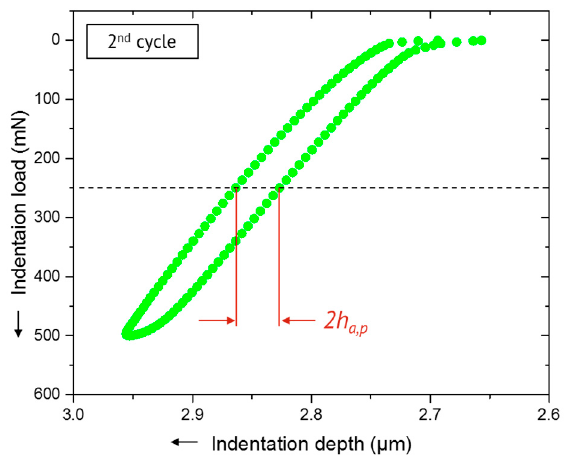
Figure 4. Hysteresis curve formed after the second indentation cycle, and plastic indentation depth amplitude h a,p at 250 mN.